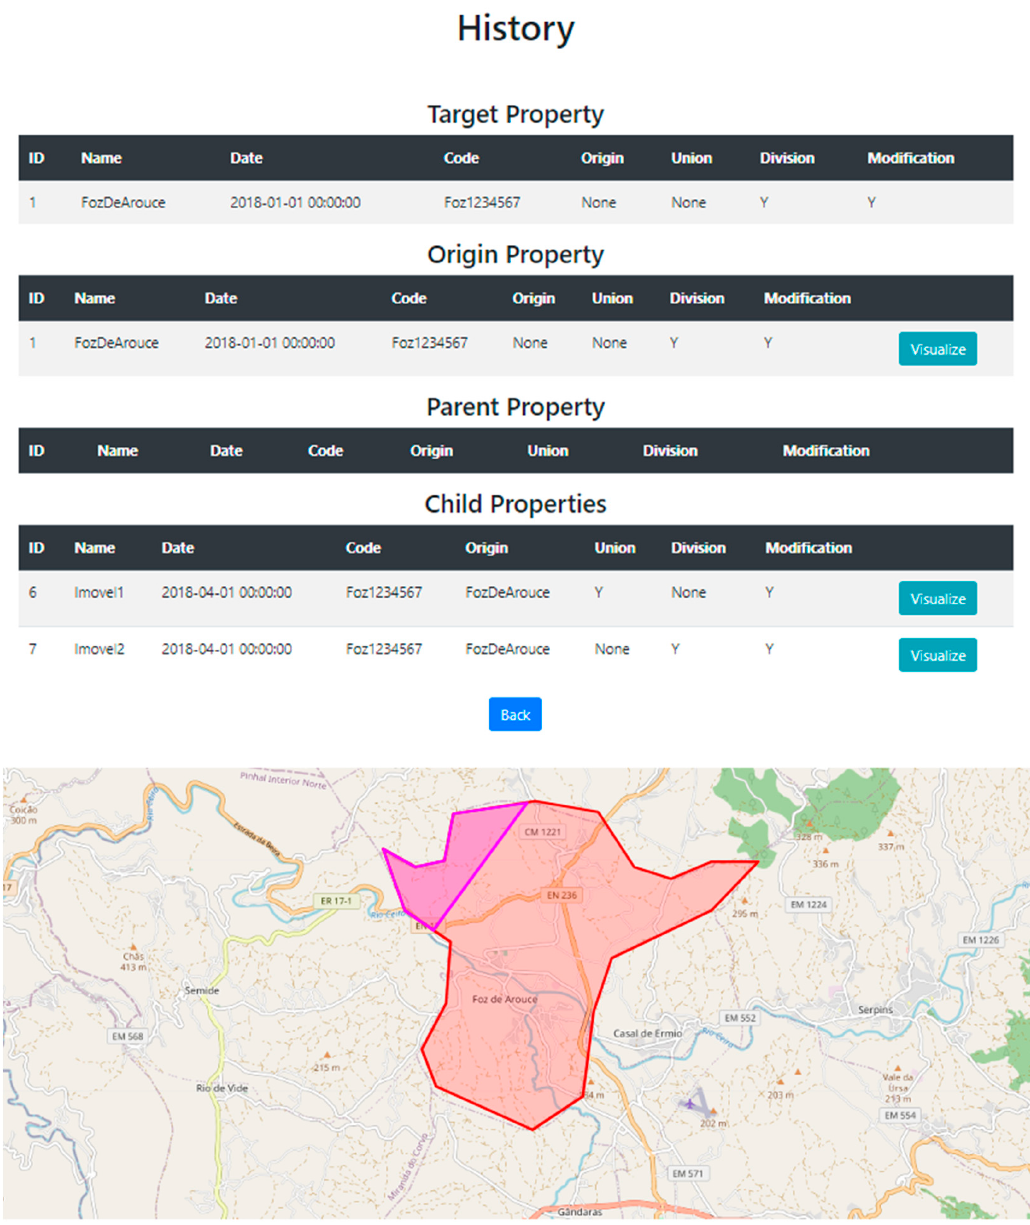
Figure 5. Visualization of the history of a property.